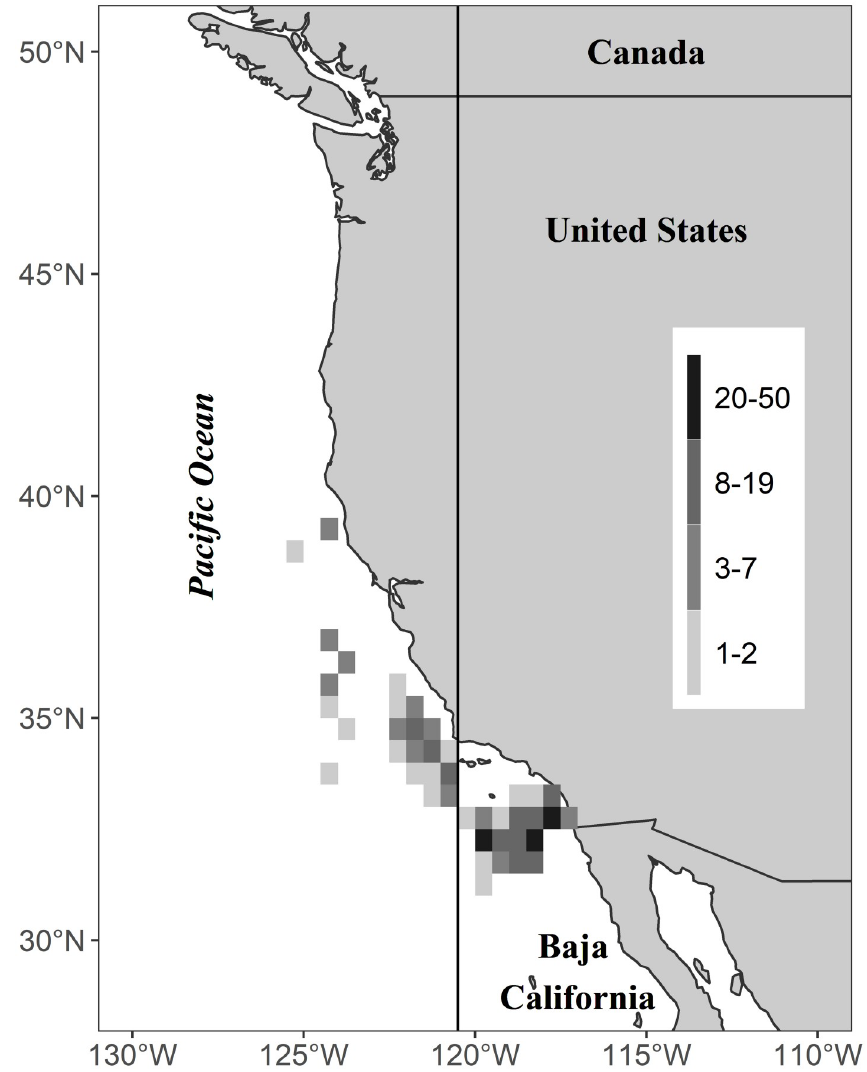
Fig 1. Collection areas of swordfish used for diet analysis. Number of samples (individuals) is indicated by greyscale in the legend. Map shows the northern part of the California Current Large Marine Ecosystem (CCLME) that extends to the tip of Baja California. Vertical line separates the two areas: within the Southern California Bight (SCB, east of 120 º 30’W) and beyond the SCB subregion (west of 120 º 30’W). The coastline was imported from the public domain Natural Earth project, via the ’maps’ package